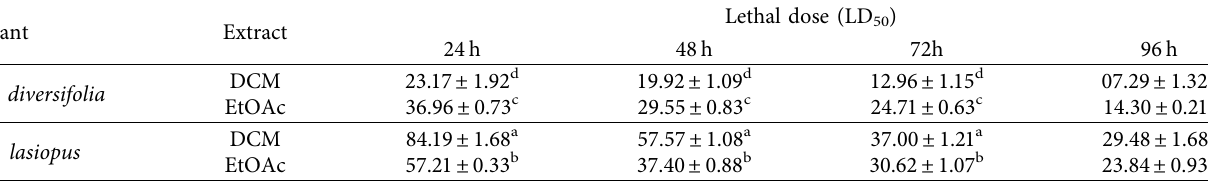
Values are expressed as mean ± SEM for four replicates per group ( n � 4). Statistical comparisons were made within column, and values followed by different superscripts.